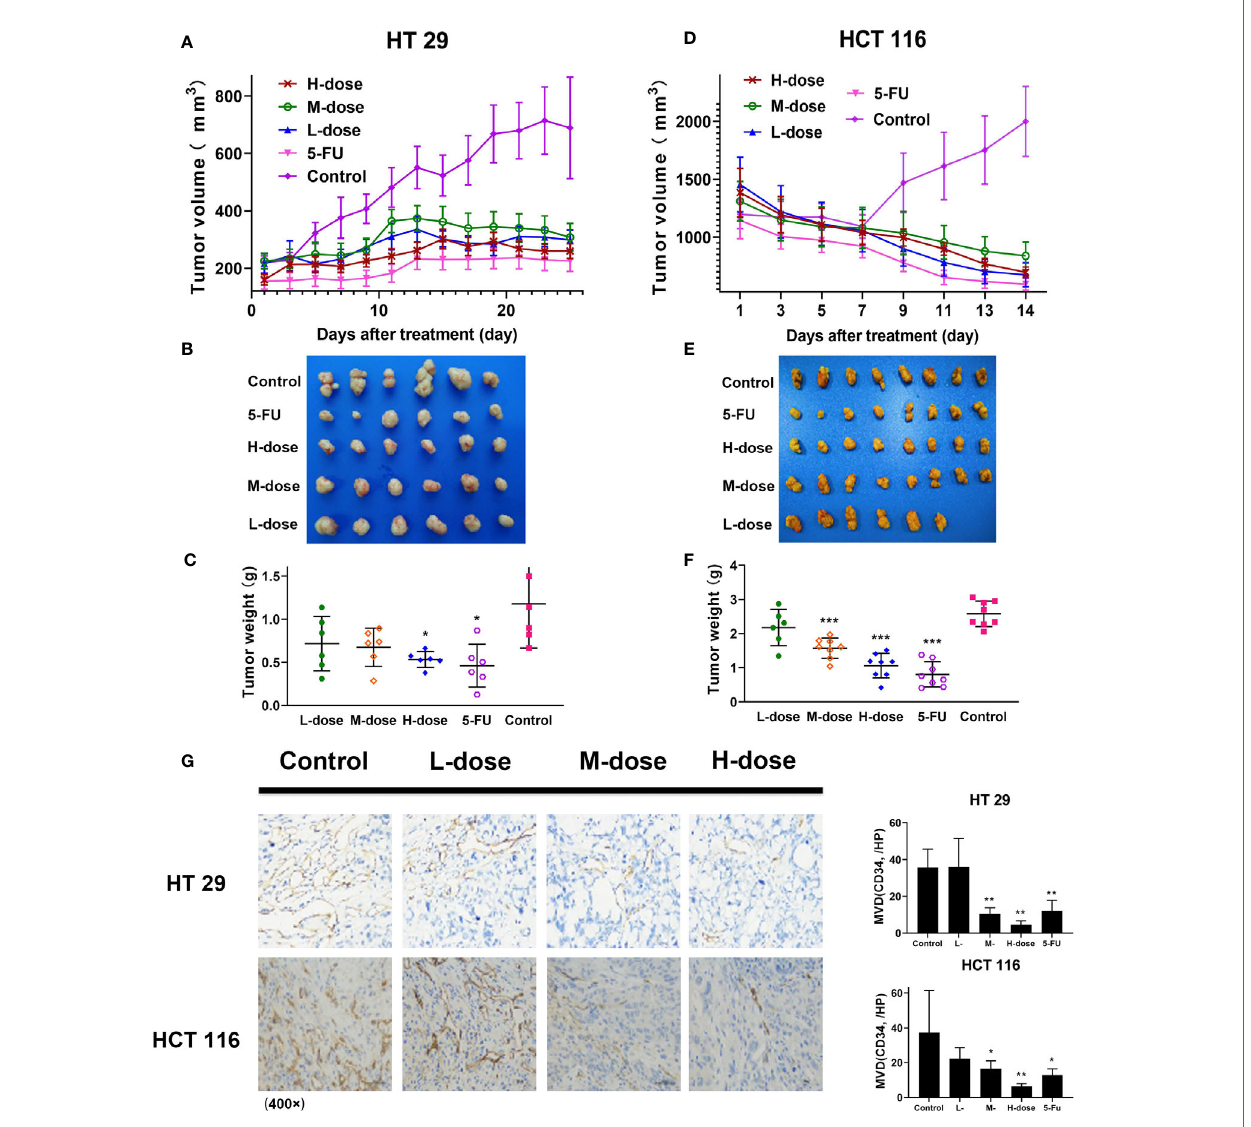
FIGURE 7 | Antitumor effect of SDEA in vivo , immunohistochemistry analysis, and MVD counts of xenograft tumor tissues in colon tumors. (A, D) Tumor volume in HT29 ( n = 6) and HCT116 ( n = 8), respectively, mean ± SEM; (B, E) images of tumor lump removed during the last treatment day; (C, F) weight of tumor lump removed during the last treatment day (B, C) (HT29), (E, F) (HCT116), mean ± SEM, HT 29 ( n = 6) and HCT 116 (n = 8), respectively (* p < 0.05; *** p < 0.001, vs. control group). (G) Effect of SDEA on the expression of CD34 staining (× 400); H, MVD counts ( n = 6, * p < 0.05; ** p < 0.01; 5-FU, i.v., 5 mg/kg/2 days; control, po., N.S.; low dose, po., 100 mg/kg/day; medium dose, po., 200 mg/kg/day; and high dose, po., 300